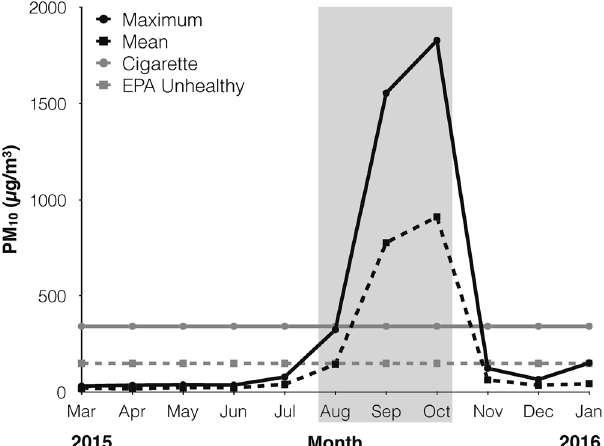
Figure 2. Maximum (solid black) and mean (dashed black) monthly PM 10 values observed in Palangkaraya across the study period. PM 10 after lighting a cigarette (solid grey) 38 and the EPA unhealthy limit (dashed grey) for reference. Light grey rectangle indicates the smoke period.